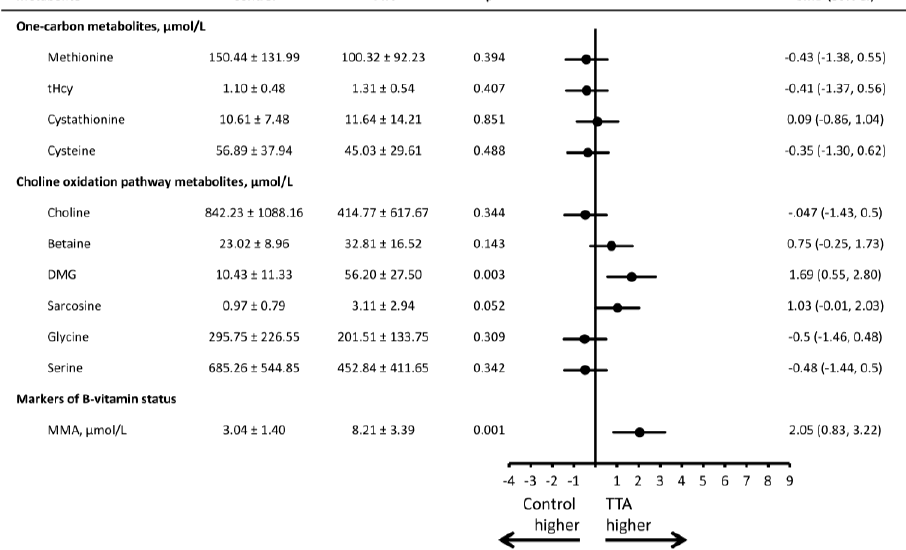
Table 1. Correlations between blood and urinary concentrations of metabolites. Male Wistar rats were treated with either a low-fat control diet or a high-fat diet with or without additional TTA treatment, n = 17. Pearson correlation coefficients were calculated between the plasma and urinary concentration of metabolites.